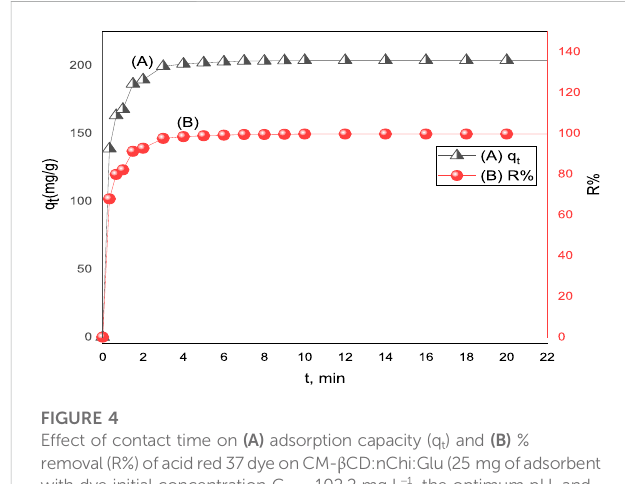
FIGURE 3 Effect of pH on (A) adsorption capacity (q e ) and (B) % removal (R%) of acid red 37 dye by CM- β CD:nChi:Glu.